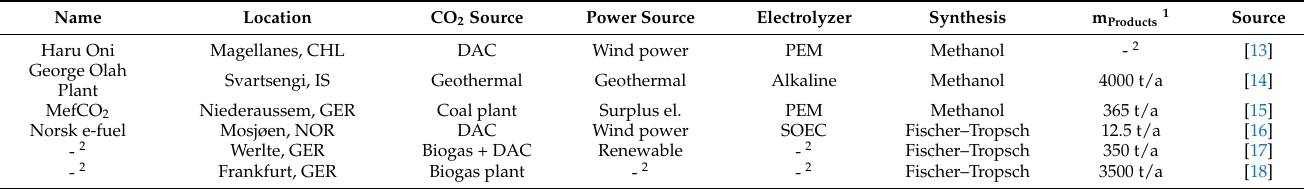
Table 1. Overview of completed and ongoing Power-to-Liquid